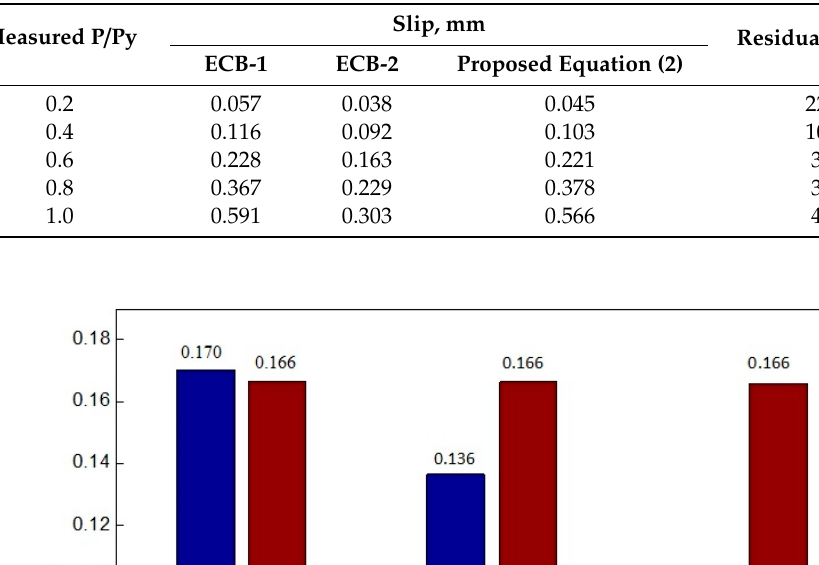
Table 5. Comparison of slip between the test results of ECBs and the proposed equation.